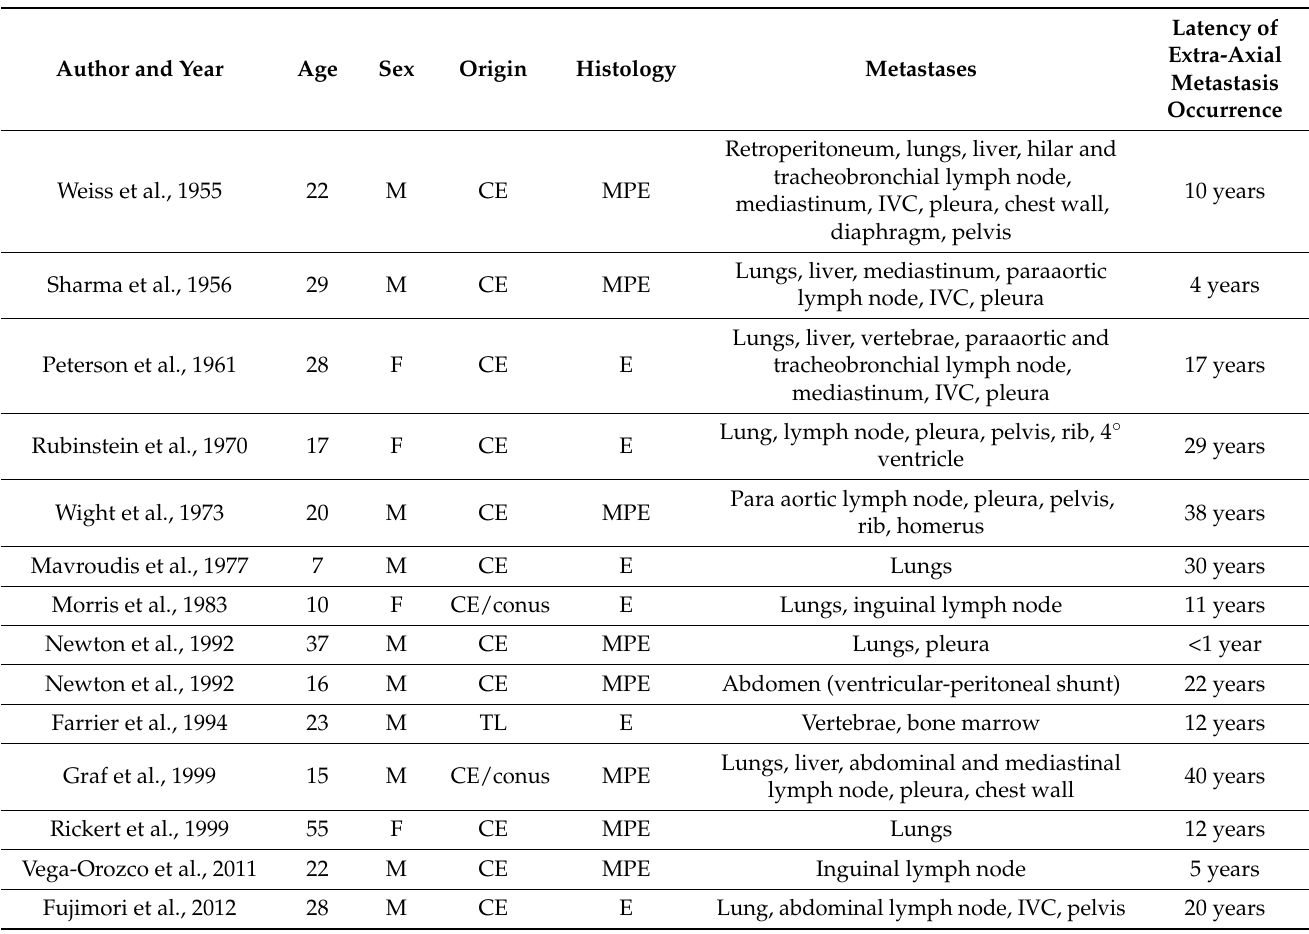
Table 2. Cases of extra CNS metastases of ependymomas published in the literature for in last 65 years (since 1955) with localization specification. The latency of extra-axial metastasis occurrence was calculated from the first